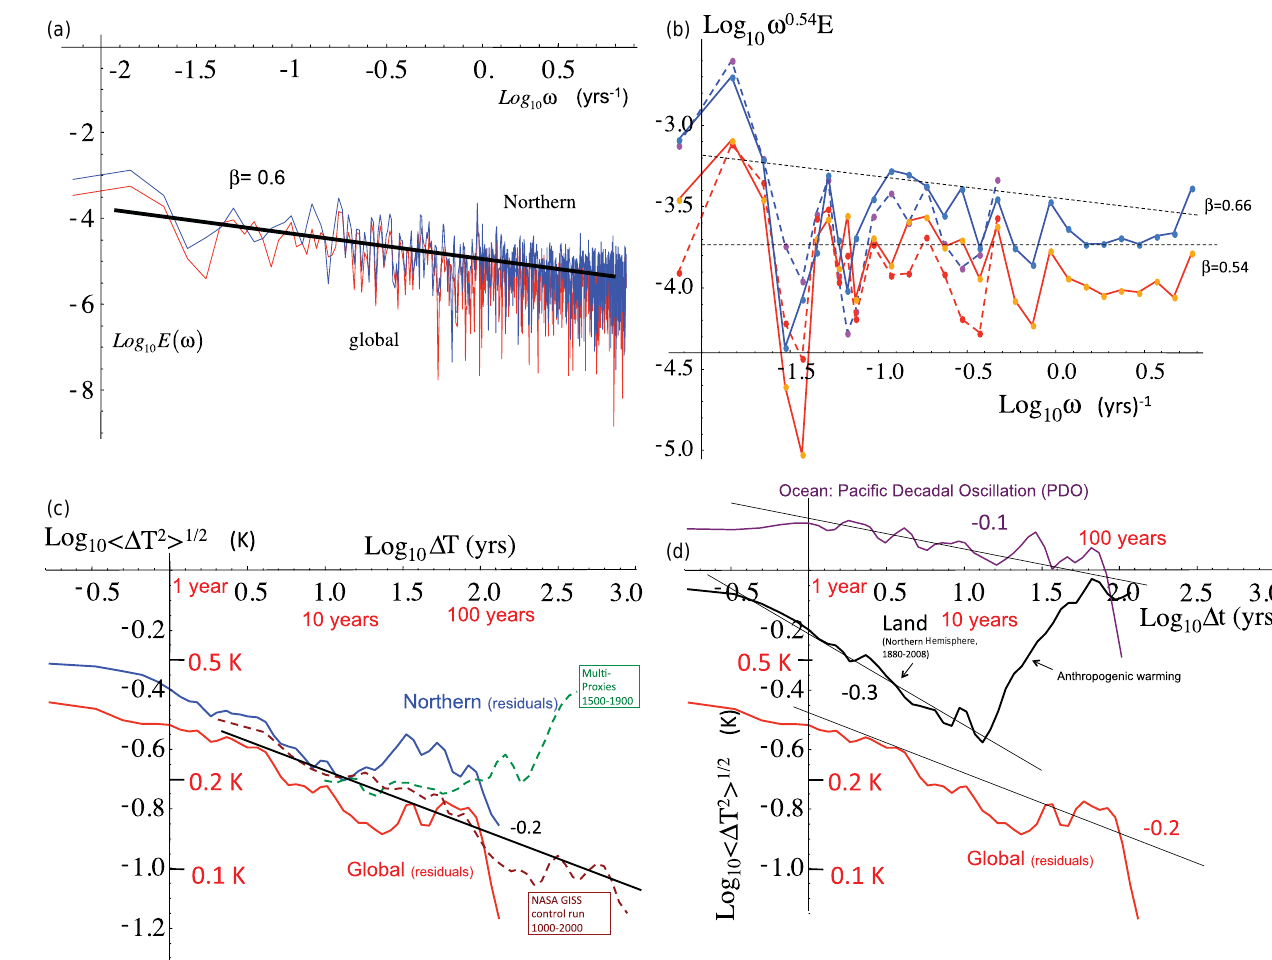
Figure 4. (a) Upper left: the spectrum of the monthly residues for northern (blue) and global (red) data. The slope β = 0.6 is shown corresponding to the best overall estimate ( H =− 0.20). (b) Upper right: the Northern Hemisphere (top, blue) and global (bottom, red) spectra, at monthly (solid) and annual (dashed) resolutions using the NASA GISS surface temperature anomaly series from 1880–2013. For frequencies higher than the lowest factor of 10, averages have been made over 10 frequency bins per order of magnitude in scale. In addition, the spectra have been “compensated for” by multiplying by ω 0 . 54 so that spectra with H =− 0.23 ( β = 0.54) appear flat. The range − 0.17 <H < − 0.23, corresponding to one standard deviation limits ( β = 1 + 2 H , i.e. ignoring small multifractal intermittency corrections), corresponds to 0.54 <β < 0.66. The lower and upper bounding reference lines are shown dashed. (c) Lower left: the RMS Haar fluctuations for the northern (blue) and global (red) monthly series. Reference lines with slopes H =− 0.2 are shown. We see that the scaling is fairly well respected up to ≈ 100 years. The raw Haar fluctuations have been multiplied by 2 (the “canonical calibration”; see Lovejoy and Schertzer, 2012a) in order to bring them closer to the anomaly fluctuations. Also shown is the NASA control run and the pre-industrial multiproxies. They all agree quantitatively very well up to about 100 years, where the pre-industrial natural climate change starts to become important. This shows that the monthly-scale residuals are almost exactly as simulated by the GISS model without any anthropogenic effects, supporting the idea that T nat is a good estimate of the natural variability. (d) Lower right: comparisons of the RMS Haar fluctuations of global-scale natural variability ( T nat ) from the lower left with those from land only (HADCRUT3, black) and from the Pacific decadal oscillation (PDO, top, purple; from Lovejoy and Schertzer (2013), Fig. 10.14). Reference lines of slopes H =− 0.1, − 0.2, − 0.3 are shown close to the curves for ocean, globe and land